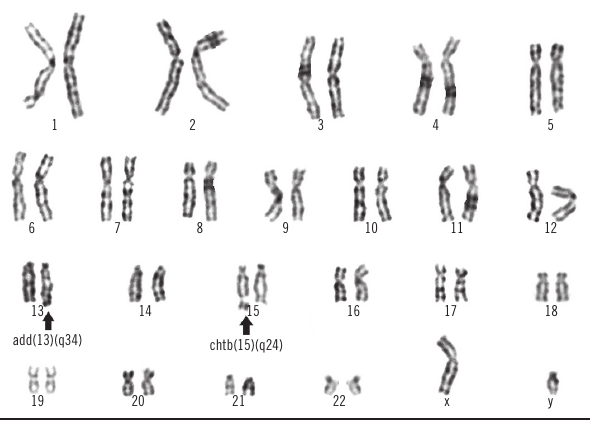
figurE − Cytogenetic analysis after one year without follow-up Cytogenetic analysis showed clonal evolution and the presence of spontaneous chromatid